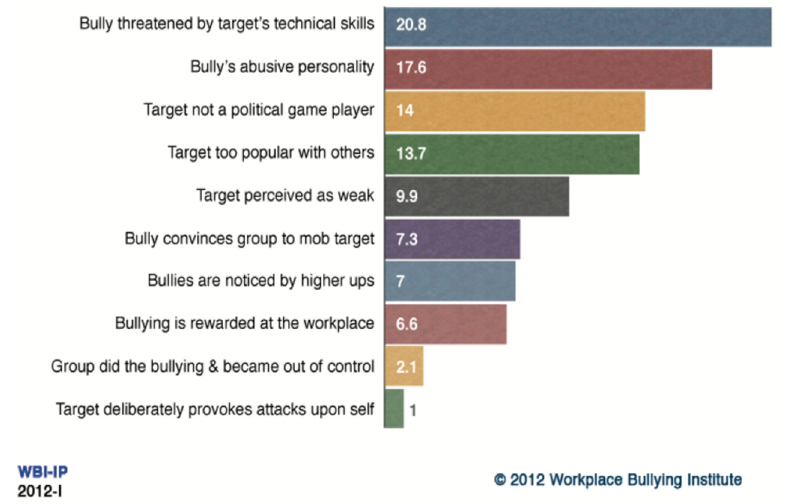
Figure 1. Reasons for being target of bullying (from Workplace Bullying Institute (WBI) 2013).